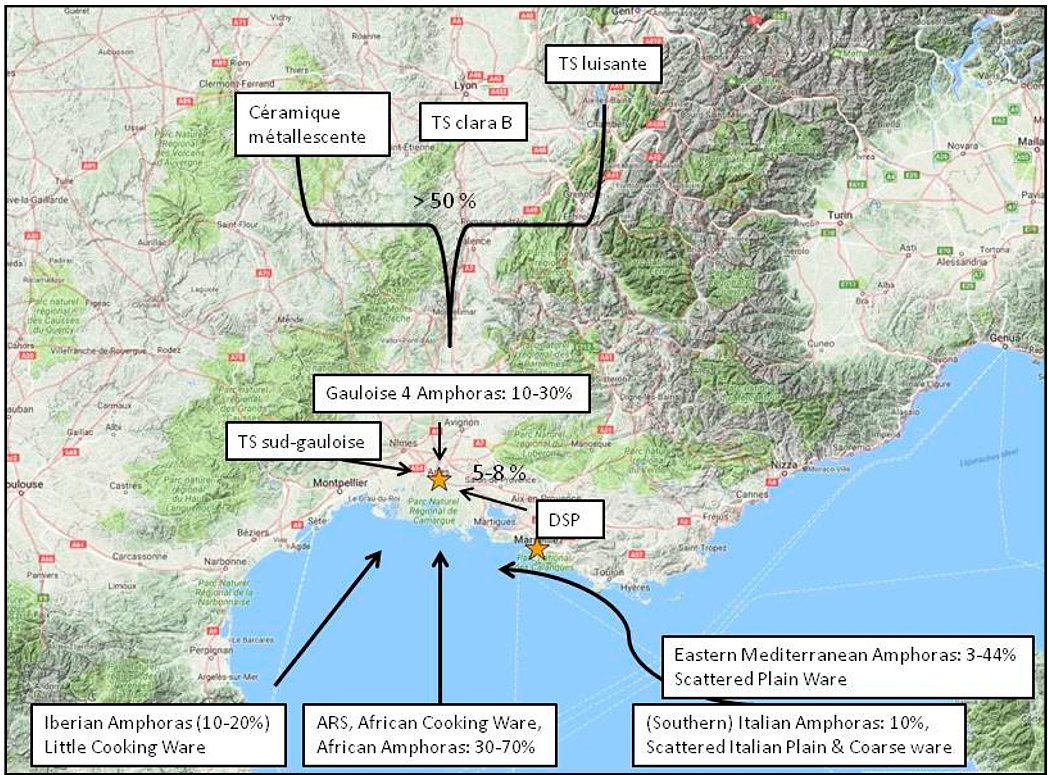
Figure 5 . Map showing the intervals of percentages of fine wares, coarse wares and amphoras from